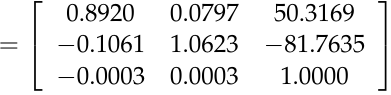
Figure 12. The rough matching results for the 0°and 35° images of the first scene: ( a ) the 0° image; ( b ) the 35° image.